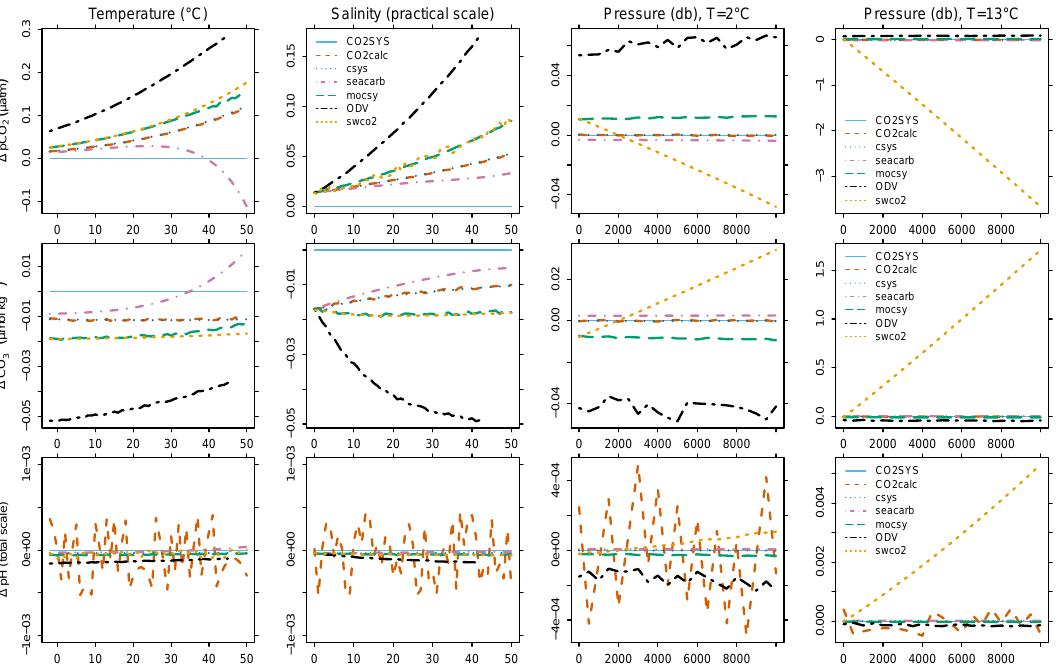
Figure 5. Variables computed from A T and C T for each package minus corresponding results from CO2SYS-MATLAB. The computed p CO 2 (top), CO 2 − (middle), and pH (bottom) are shown across ranges of T (column 1), S (column 2), and P when T = 2 ◦ C (column 3) 3 and when T = 13 ◦ C (column 4). For each range, there is one curve per package and per variable.